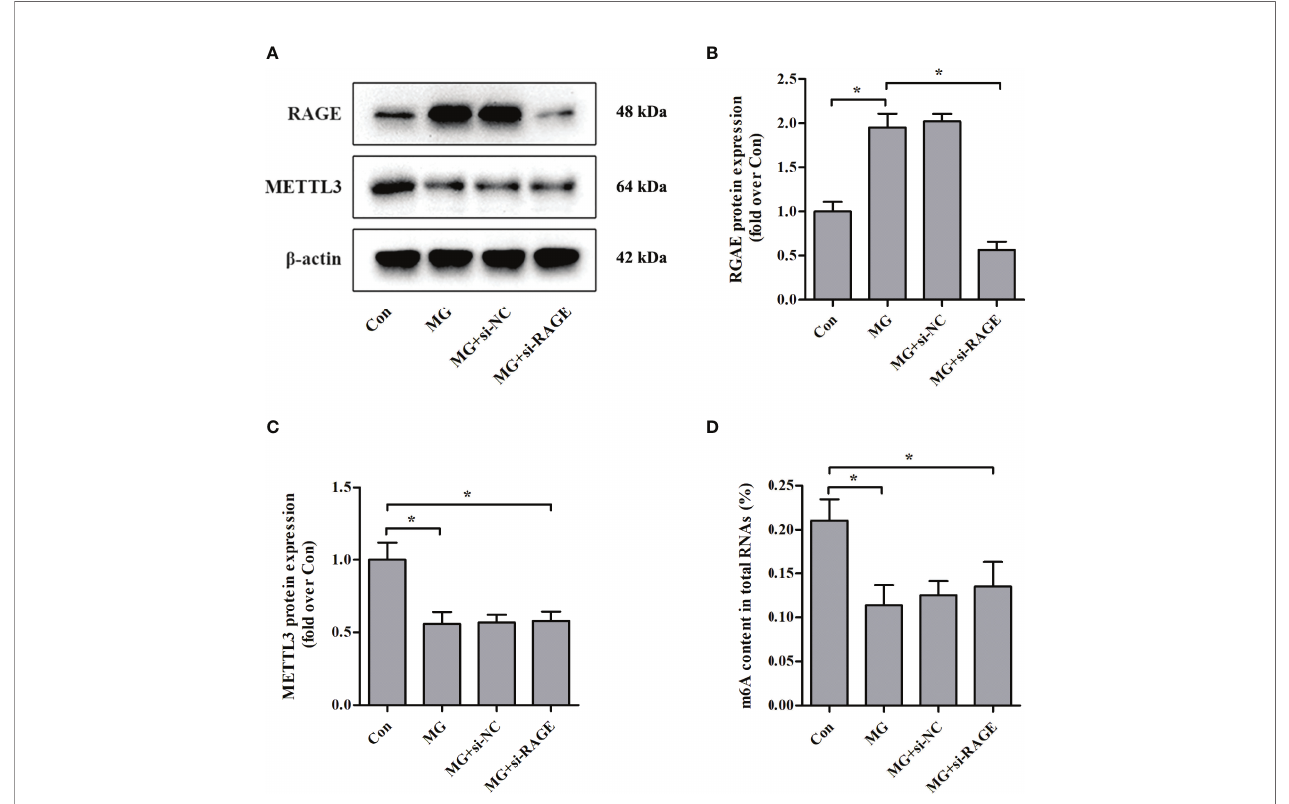
FIGURE 3 | Effects of RAGE knockdown on METTL3 expression and m 6 A RNA methylation levels in NIT-1 cells. (A – C) Immunoblotting of RAGE and METTL3 protein expression in NIT-1 cells transfected with RAGE siRNA (si-RAGE) or a nonspeci fi c control siRNA (si-NC) and treated with 1 mM of MG for 24 h. (D) m 6 A levels in total RNA from NIT-1 cells treated as described for (A – C) . Results are presented as the means ± SD of n = 3 – 4 independent experiments. * p <